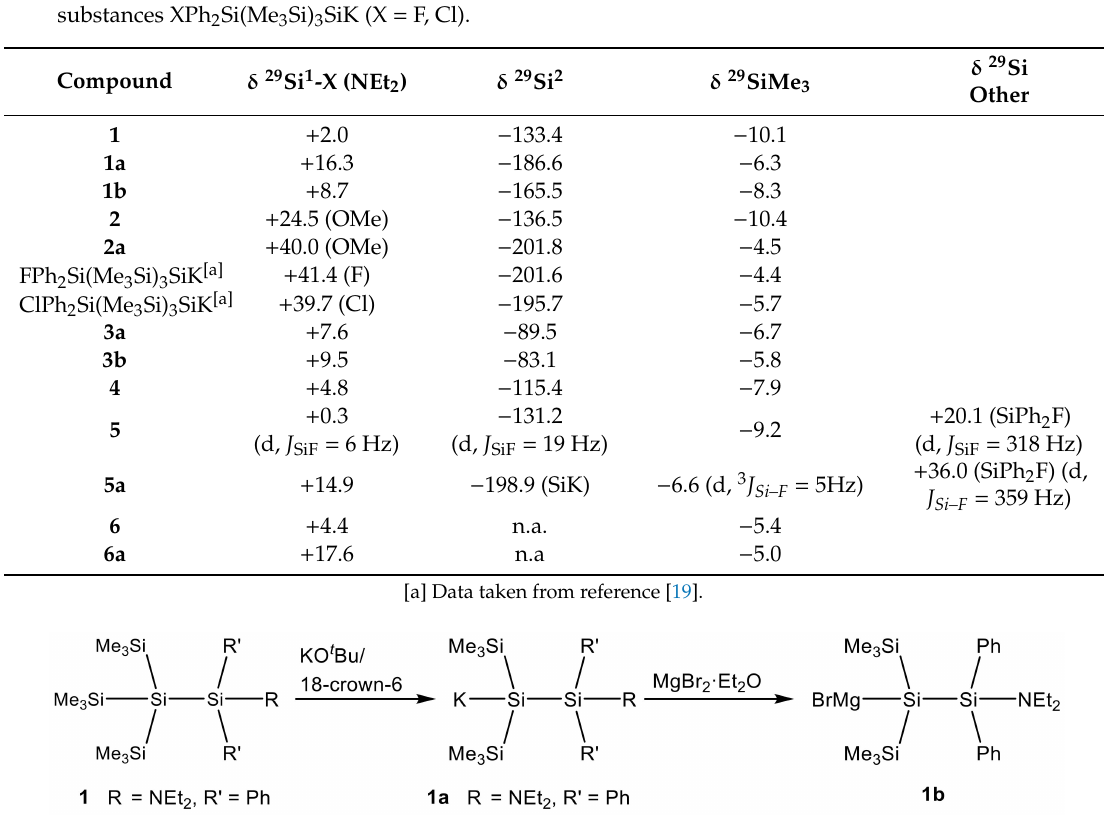
Table 2. 29 Si-NMR chemical shift data for 1 , 1a , 1b , 2 , 2a , 3a , 3b , 4 , 5 , 5a , 6 , 6a and the